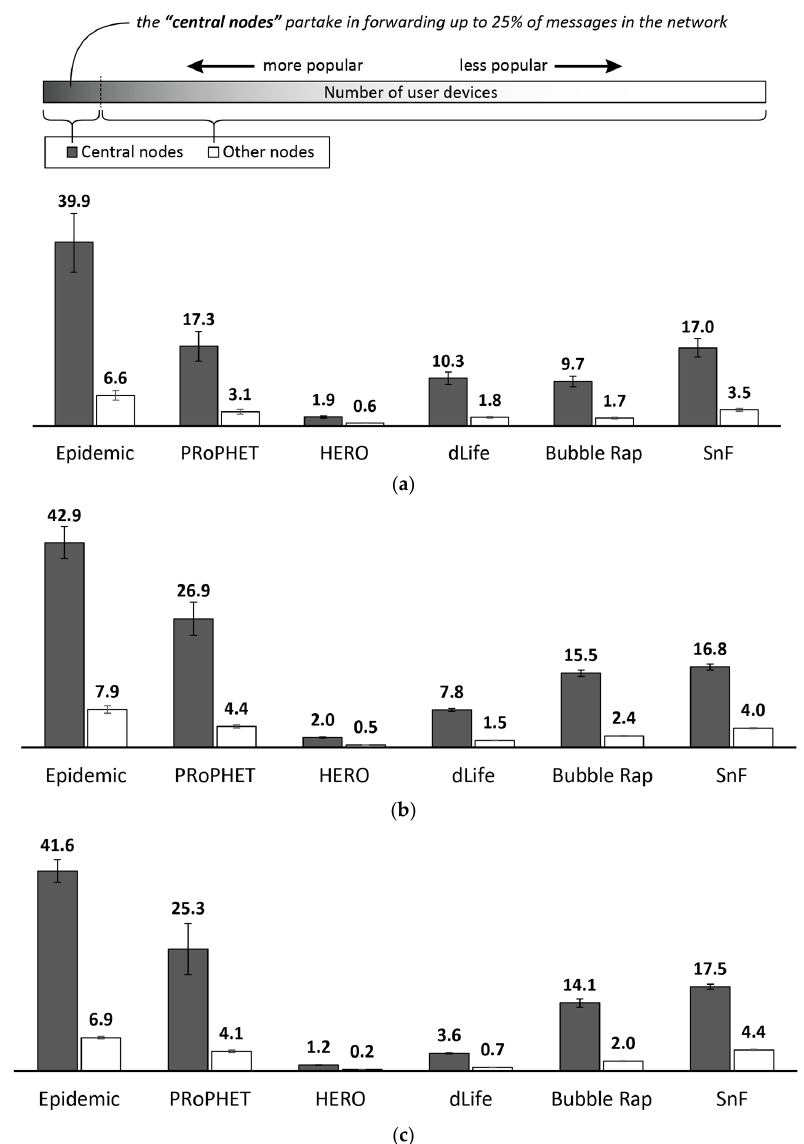
Figure 3. The average percentage of initial energy consumed on the central nodes and the other nodes under ( a ) low locality; ( b ) medium locality; ( c ) high locality.